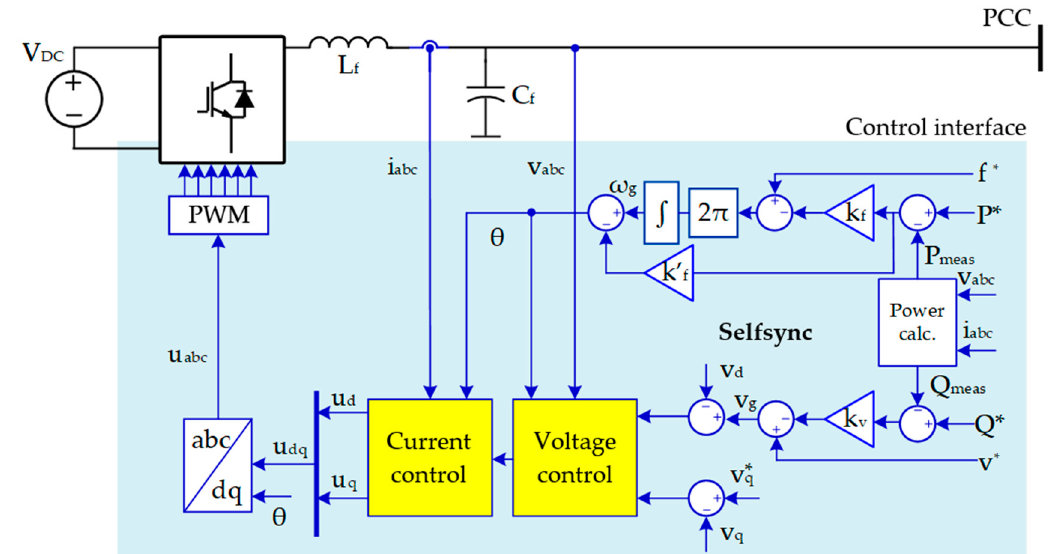
Figure 11. Selfsync implementation of grid-forming droop control [28].